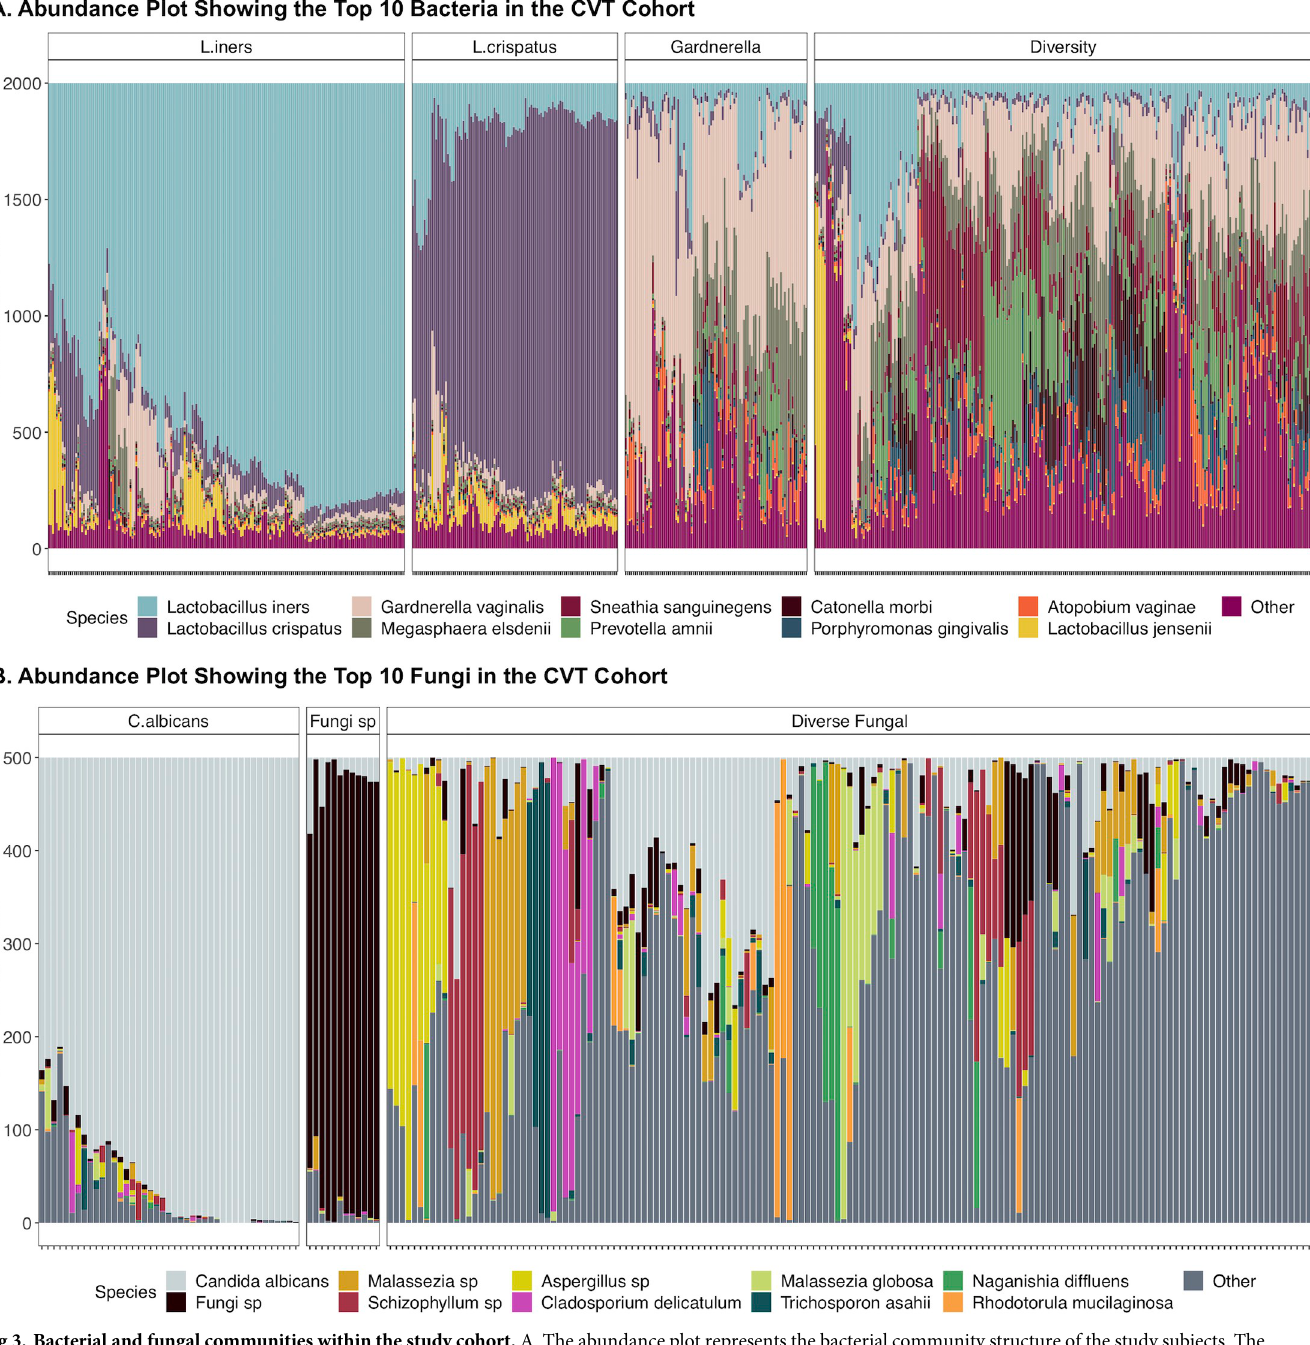
progression vs. clearance revealed a total of 24 taxa that were significant (LDA > 2.0) at V1. G .